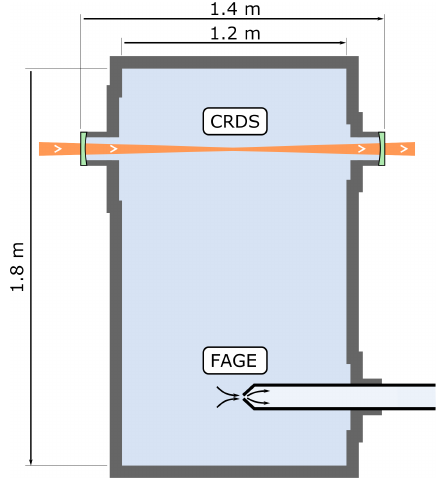
Figure 2. Longitudinal (horizontal) section of the HIRAC chamber. The CRDS spectrometer probes the CH 3 O 2 concentration as an av- erage across the chamber’s diameter, while the FAGE instrument probes CH 3 O 2 in the chamber at a single point close to the